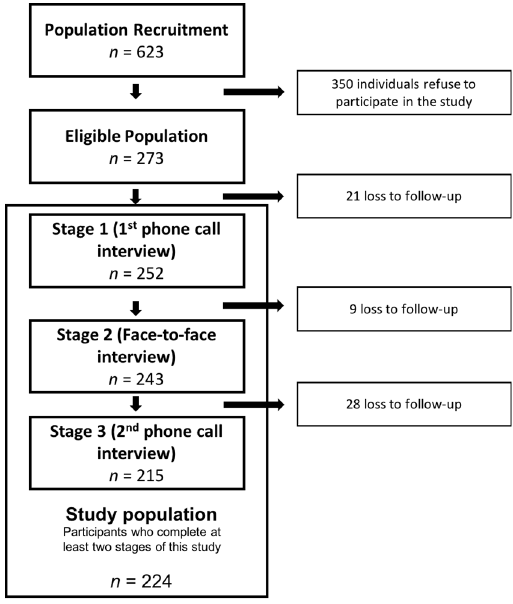
Figure 1. Flowchart of the validation study of a telephone-administered version of the Mediterranean Diet Adherence Screener (MEDAS) questionnaire in the adult Portuguese population.